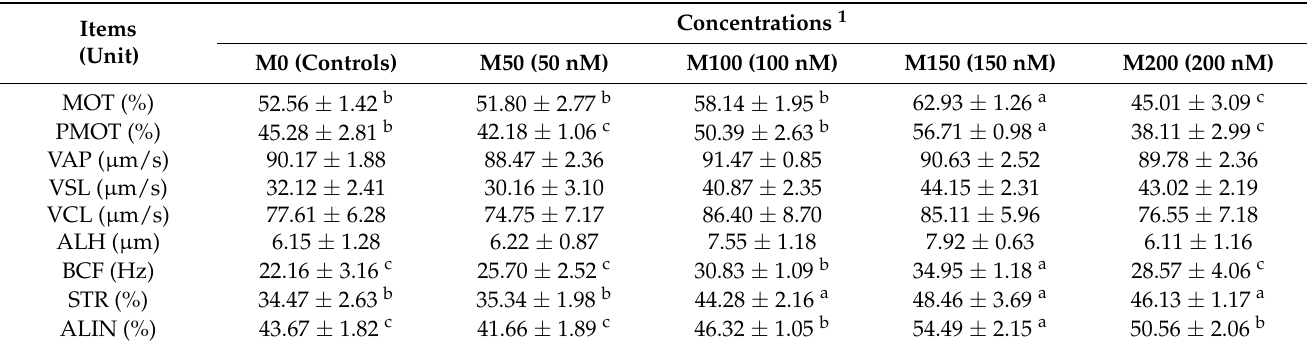
Table 1. Influence of different concentrations of mitoquinone (MitoQ) on the motility parameters of rooster sperm assessed by CASA.